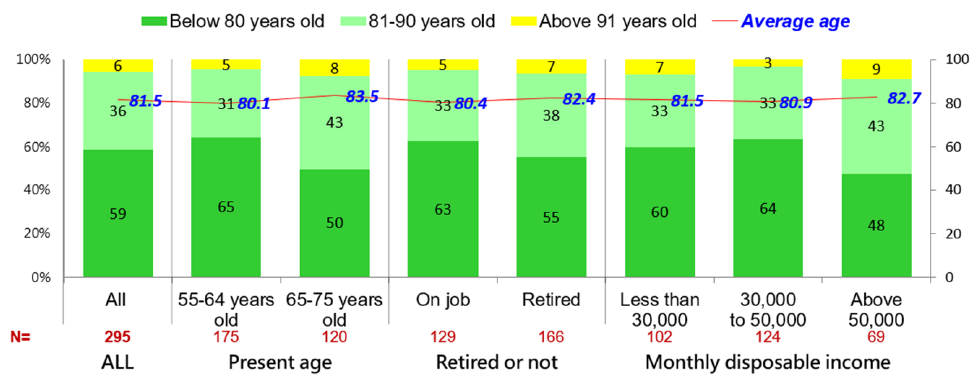
Figure 3. Predicted age of self-health and autonomous non-bedridden life for those aged 55–75 years old.